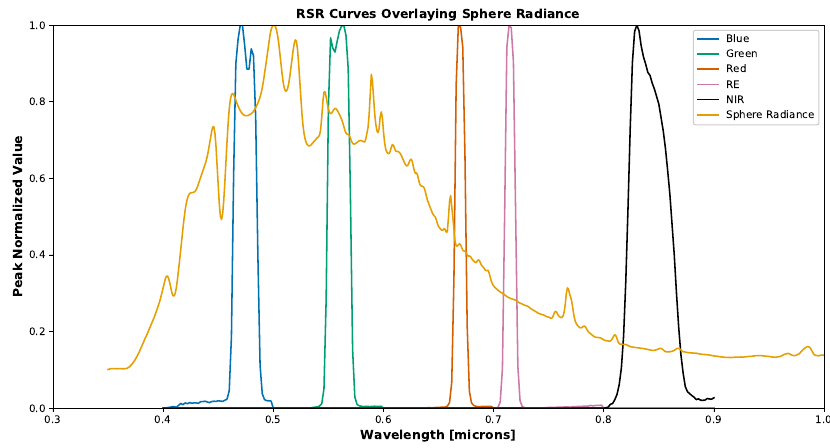
Figure 23. Peak normalized MicaSense RedEdge-3 RSR curves overlaid onto normalized spectral radiance